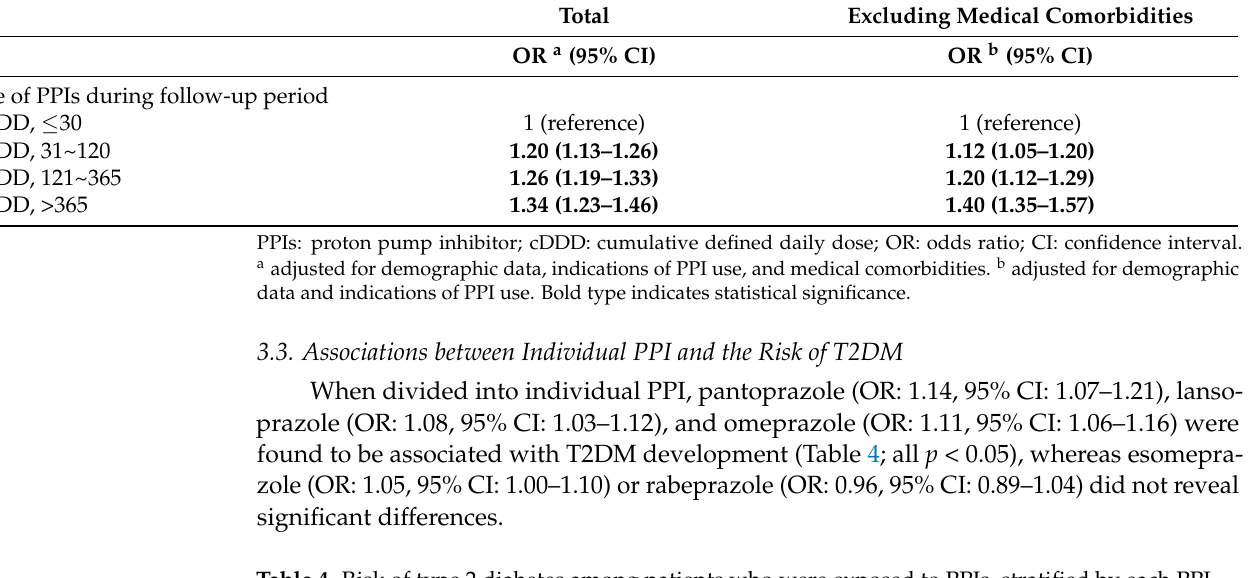
Table 4. Risk of type 2 diabetes among patients who were exposed to PPIs, stratified by each PPI. With